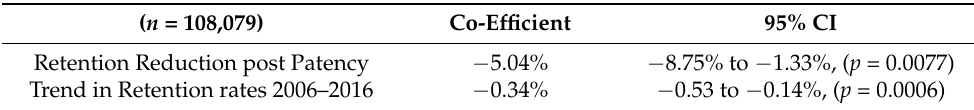
Table 3. Trends in retention rates (data from Wang et al.